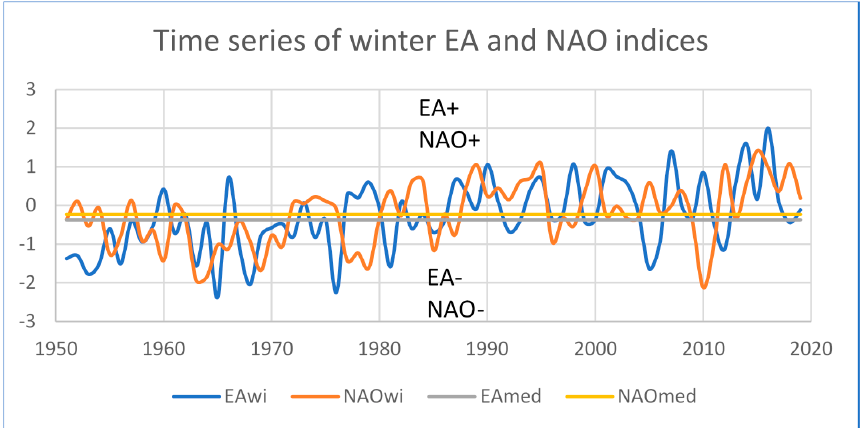
Figure 1. EA and NAO winter indices, period 1950–2019. Median values (EA med and NAO med ) are indicated.